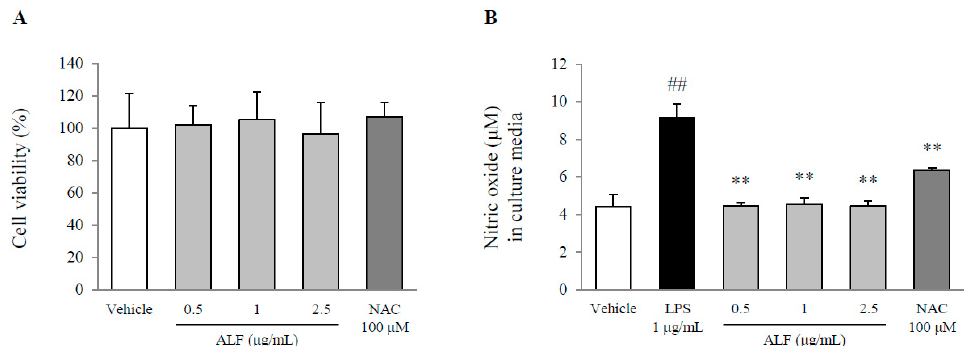
Figure 2. Cell viability and nitric oxide levels. BV2 cells were pretreated with ALF for 2 h before exposure to lipopolysaccharide (LPS) (1 μ g/mL) for 24 h. The cytotoxicity of ALF ( A ) and the levels of nitric oxide ( B ) in BV2 cells were determined. The data are expressed as the mean ± SD ( n = 6). ## p < 0.01 compared with the vehicle-treated cells; * p < 0.05 and ** p < 0.01 compared with the LPS-treated BV2 cells.